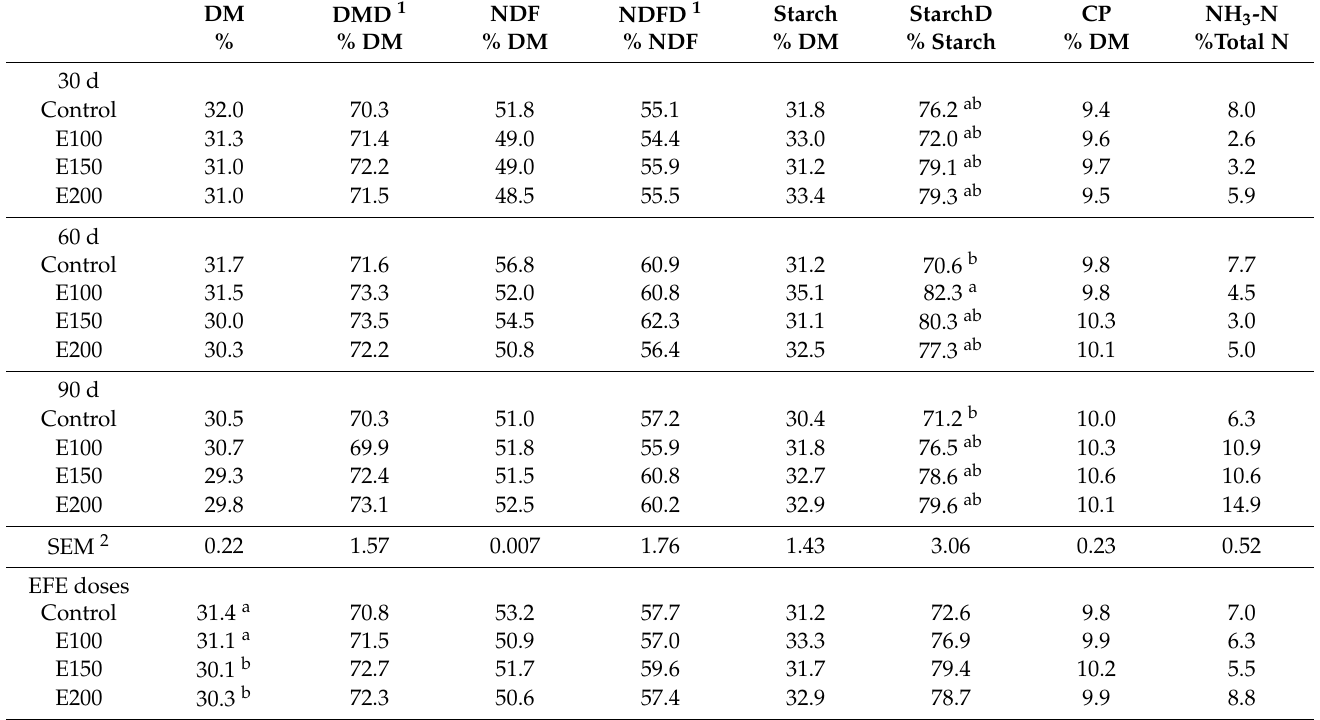
Table 1. Chemical composition and 48 h in situ digestibility of maize silages treated with exogenous fibrolytic enzymes (EFEs) at 0, 100, 150 and 200 g/ton of DM ensiled for 30, 60 and 90